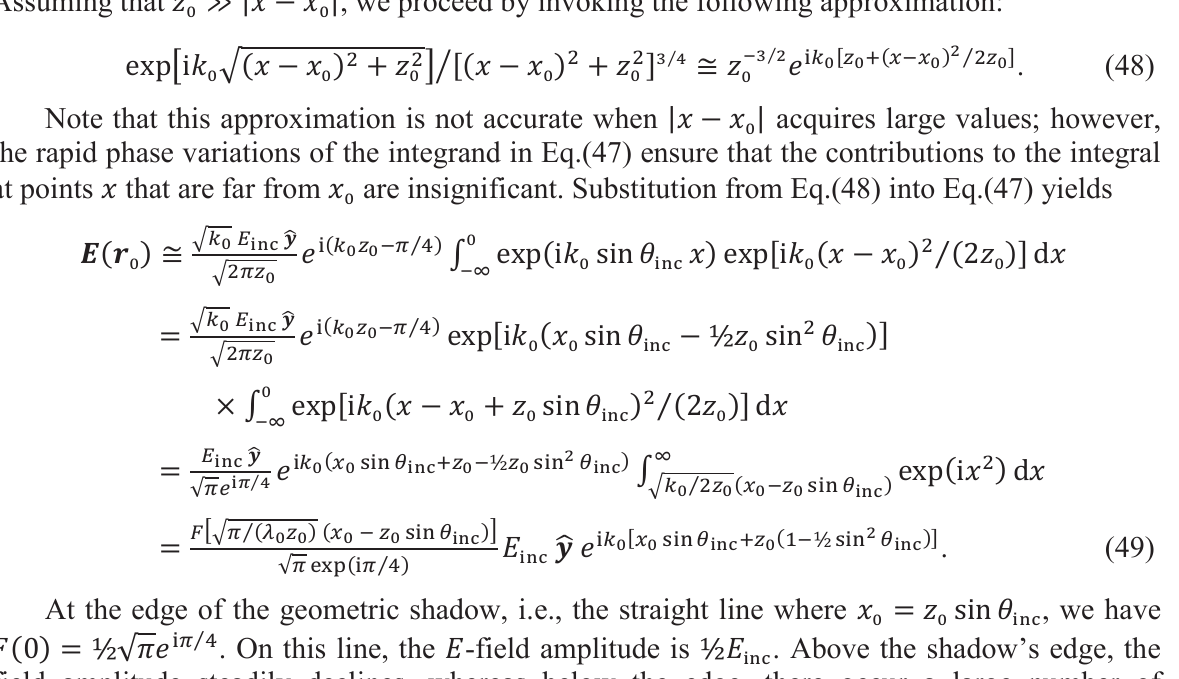
= (cid:1878) sin (cid:2016) (cid:3116) (cid:3116) (cid:3167)(cid:3172)(cid:3161)